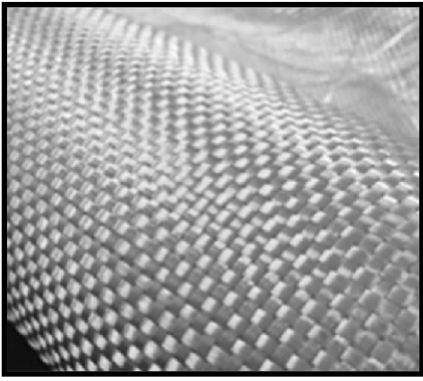
Fig. 1 Bi-directional glass fiber reinforced polymer